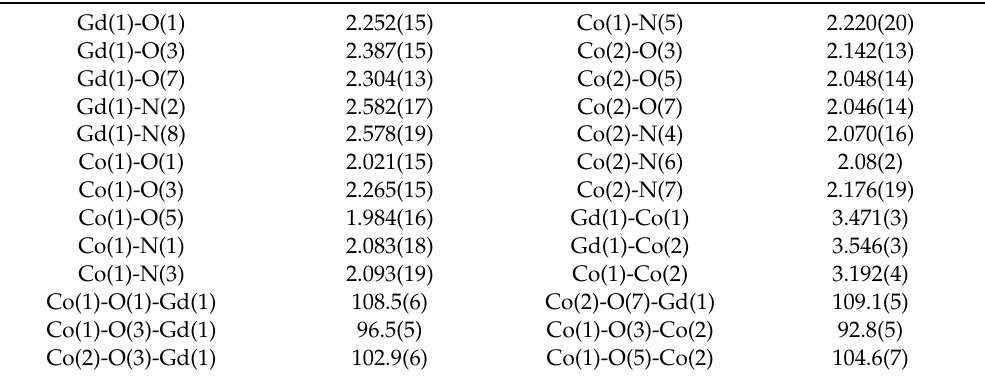
Figure 1. Structure of the cationic cluster 1 . The hydrogen atoms and the counteranions were omitted for clarity. Table 1. Selected interatomic distances (Å) and angles (degrees) for 1 .